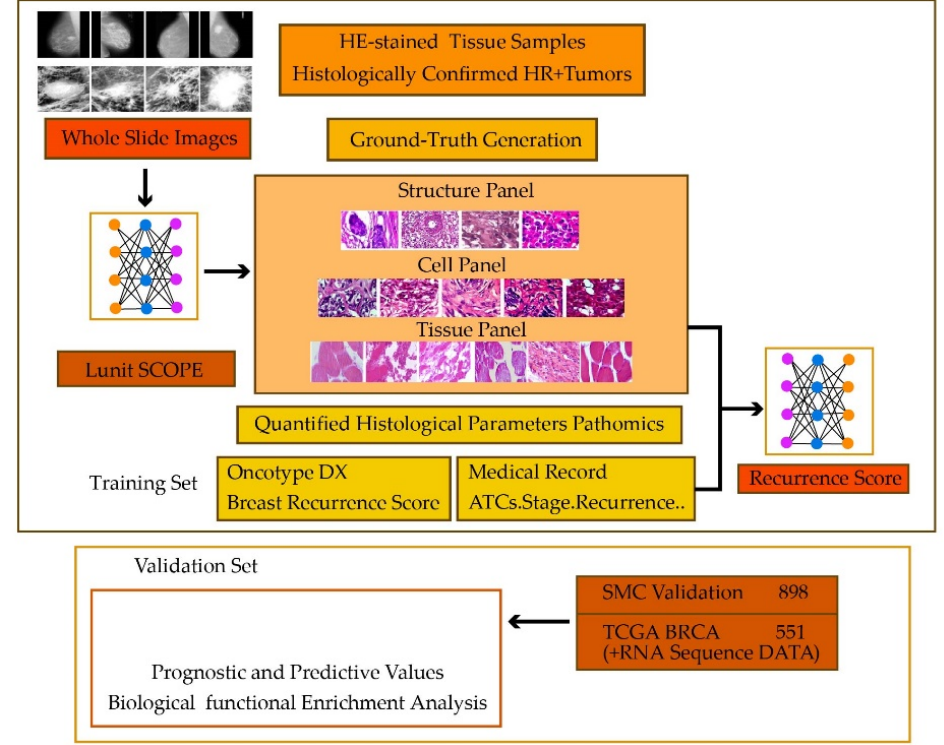
Figure 3. Chemotherapy in hormone receptor-positive breast cancer patients.